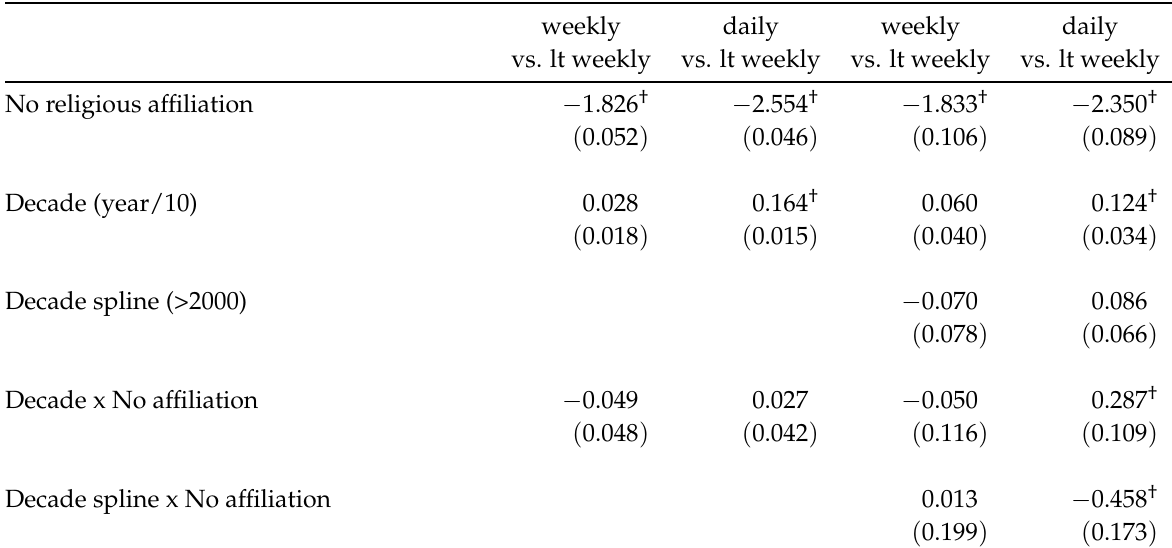
Table 4: Multinomial logit models predicting the frequency of prayer based on General Social Survey data. weekly daily weekly daily vs. lt weekly vs. lt weekly vs. lt